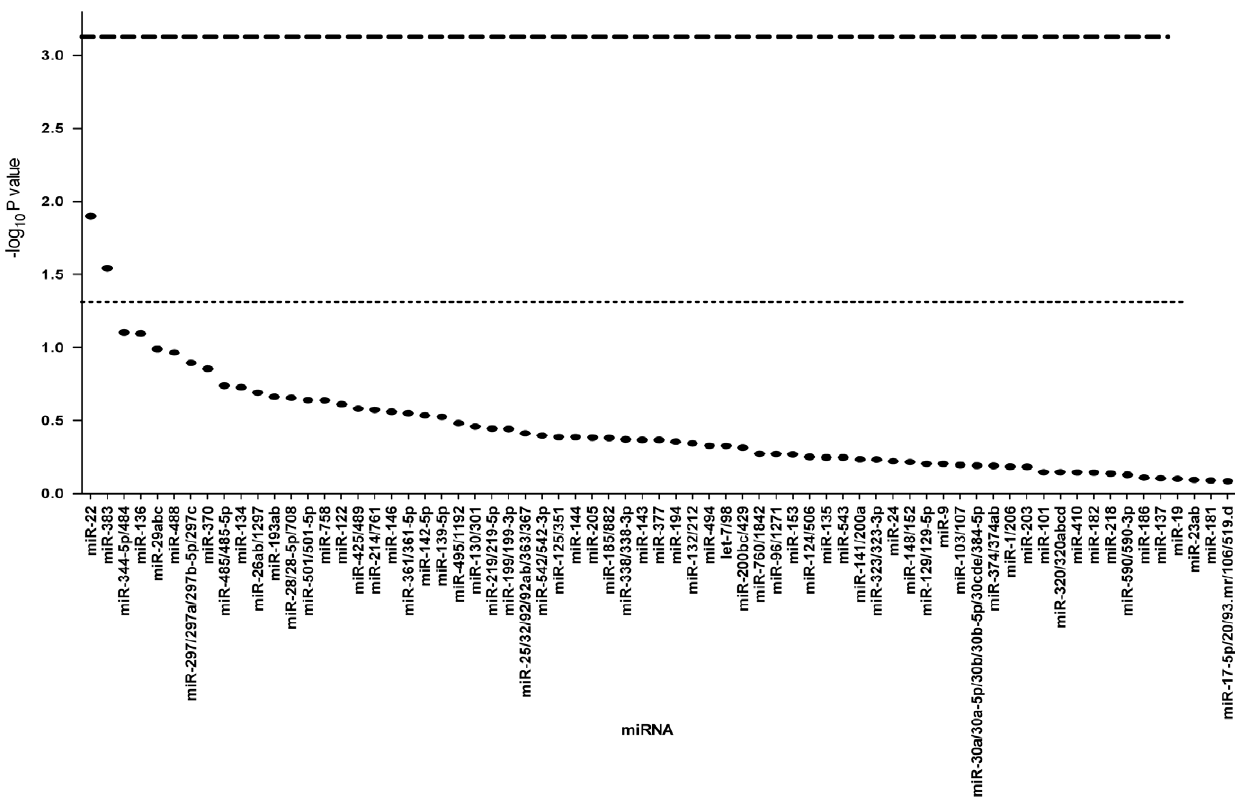
Figure 1. Statistical analysis of predicted microRNA targeting in the one-carbon metabolism (OCM) pathway. For each microRNA, the empirical p-value for the level of enrichment of predicted target sites in OCM genes (Methods) is shown. Analysis is restricted to predicted target sites that, together with their cognate microRNAs, are conserved between humans and at least two other mammalian species among mouse, rat and dog. Lower dashed line indicates p=0.05; upper dashed line indicates equivalent significance level after correction for multiple hypothesis testing.